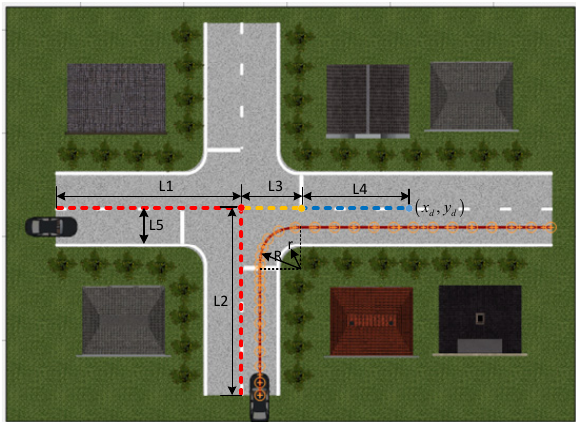
Table 2. Road model parameters in cosimulation.